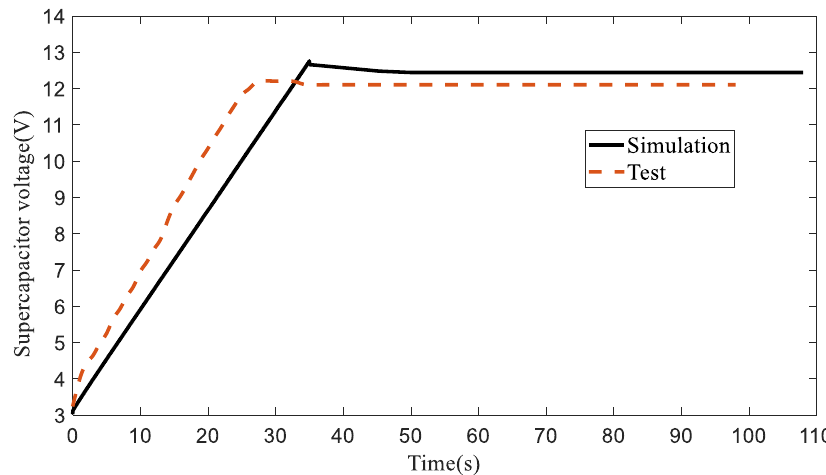
Figure 5. Variation curve of supercapacitor voltage with time.